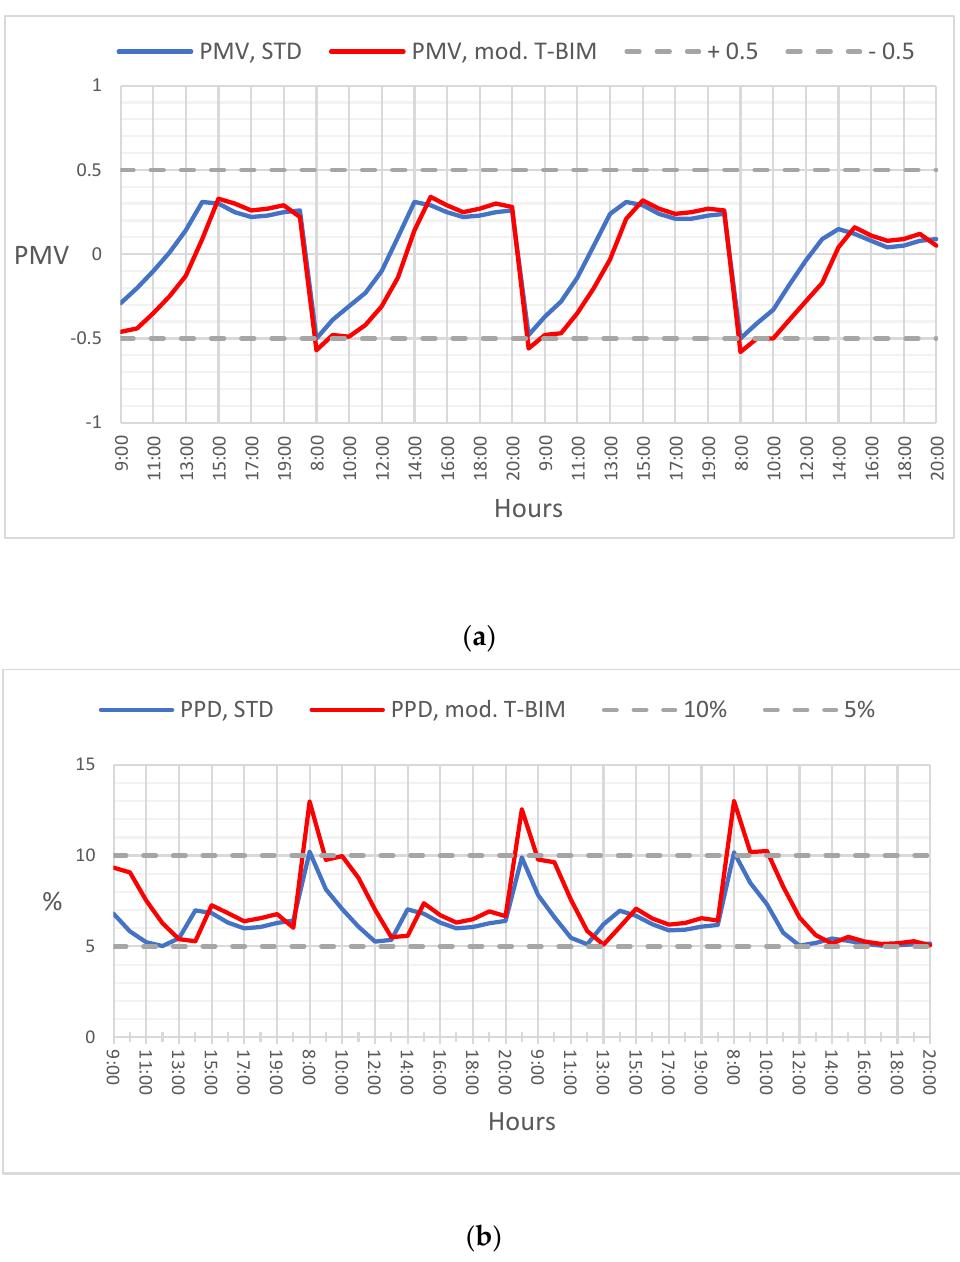
Figure 14. Hourly values of Fanger comfort parameters for zone W1 on 18–20November of TMY 2007–2021: ( a ) PMV and ( b ) PPD.